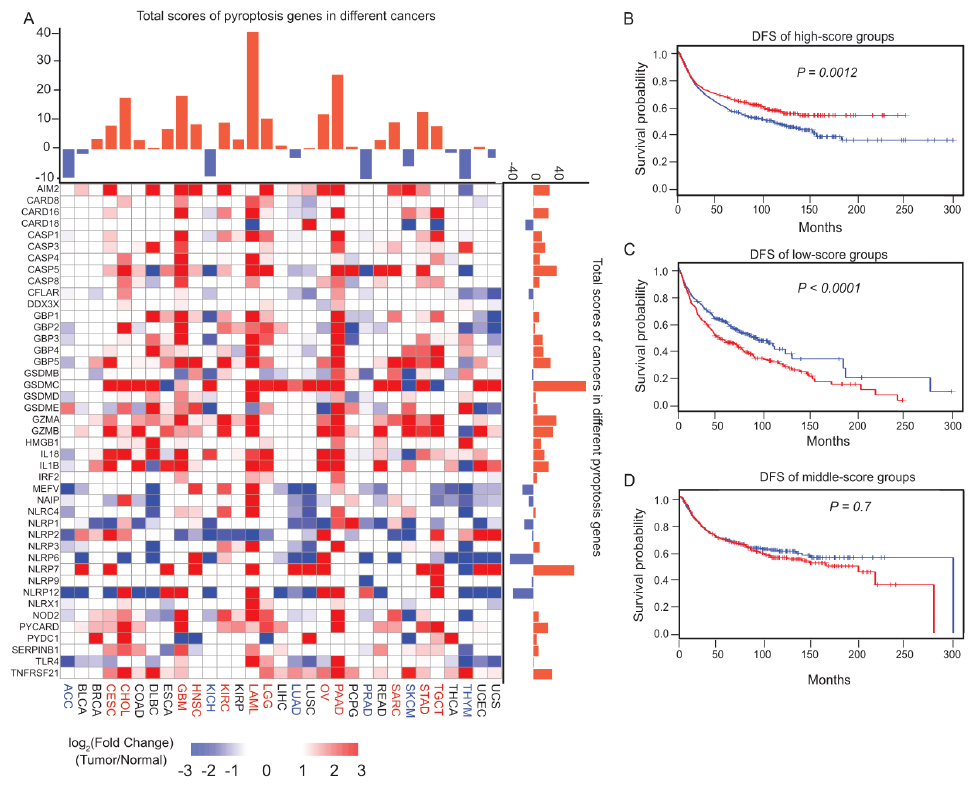
Figure 2. Pan-cancer analysis of PRGs. ( A ) The bars of the upper panel show the sums of different multiples of differentially expressed genes, and the heatmap shows the fold changes of PRGs (Tu- mor/Normal) in each cancer type (lower panel). The bars on the right of the lower panel show the sums of different multiples of genes across different cancer types. The names of the cancer types are in red for the high-score group, in blue for the low-score group, and in black for the middle-score group. Significantly upregulated and downregulated genes are marked in red and blue, respectively. ( B – D ) Kaplan-Meier curves for the disease-free survival (DFS) of samples in the high-score ( B ), low-score ( C ), and the middle-score ( D )